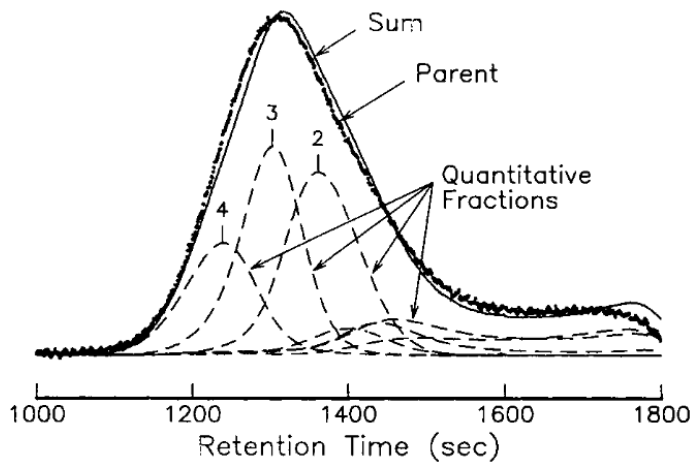
Figure 8. Gel permeation chromatogram of stock and fractionated PDMS samples separated at 70 °C. Reproduced with permission from Ref [93], copyright 1995 John Wiley and Sons.